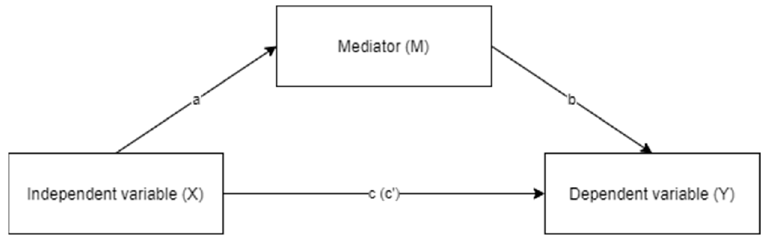
Figure 1. Diagram of the tested simple mediation model.